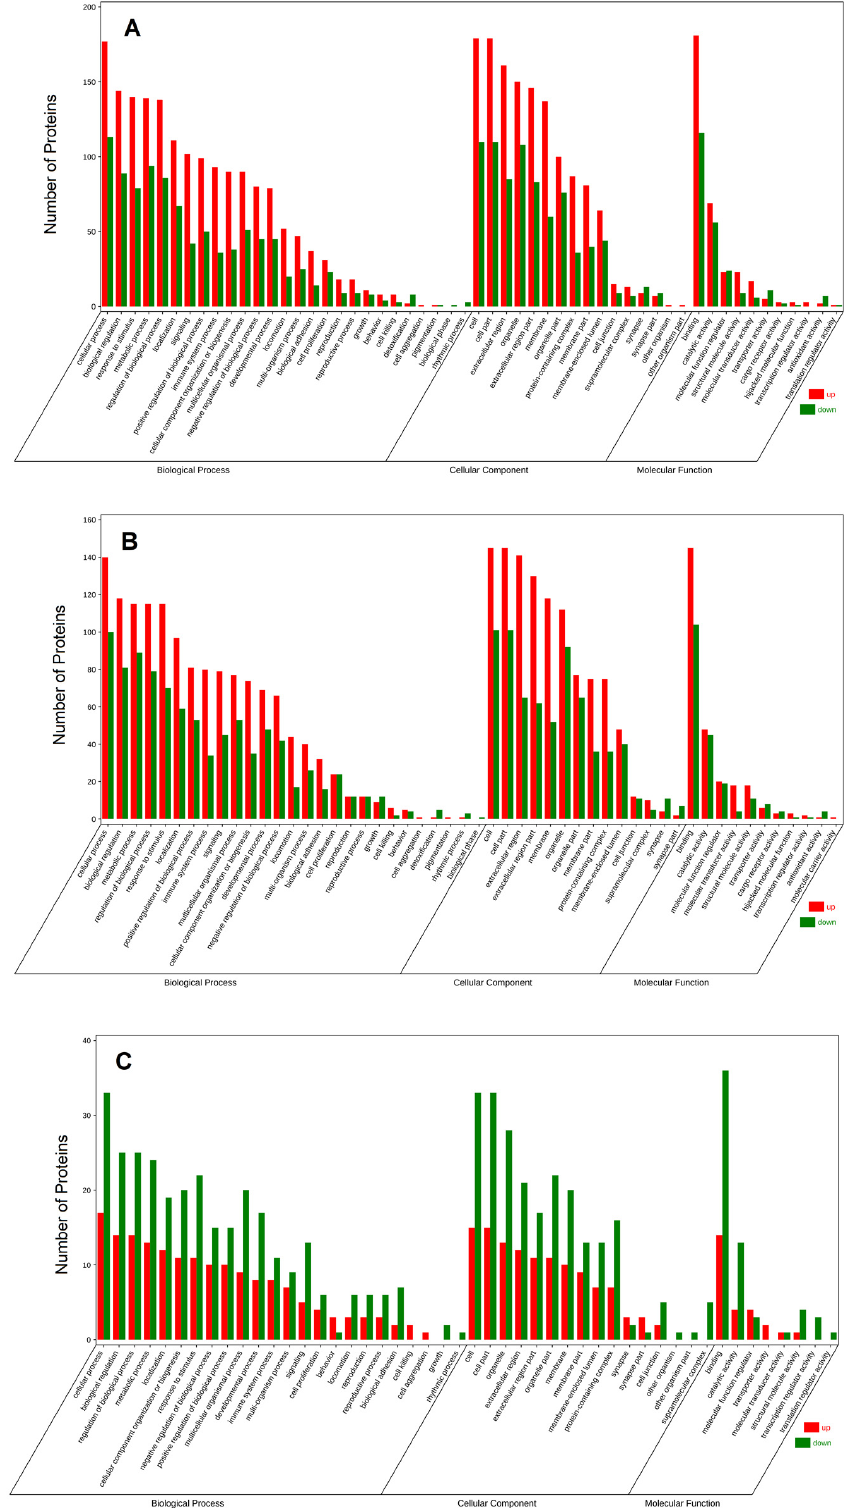
Figure 4. GO annotation of differentially expressed proteins in C vs. M ( A ), C vs. T ( B ), and M vs. T ( C ).